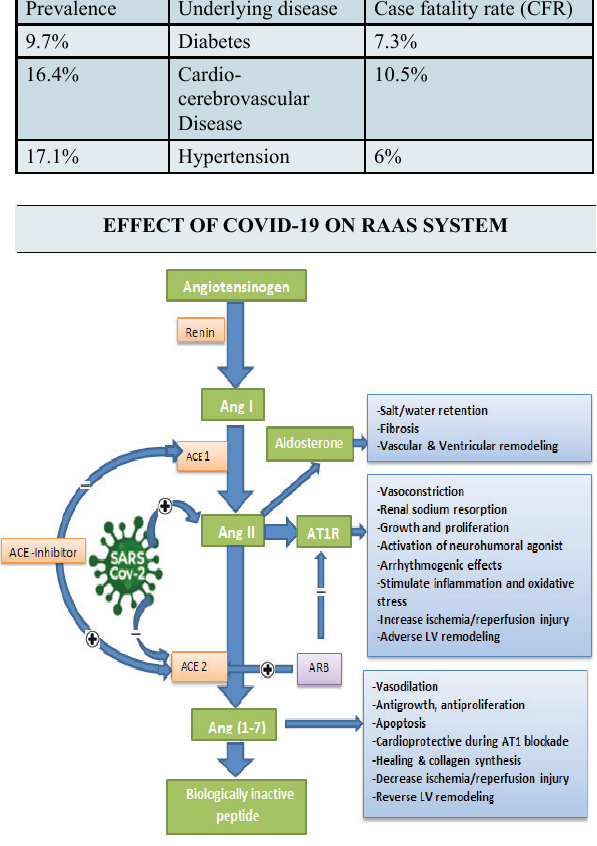
Figure 3: ACE mediated damage by SARS-CoV-2. (ACE- 1, Angiotensin-converting enzyme 1; ACE-2, Angiotensin- converting enzyme 2; Ang I, angiotensin I; AT1R, angiotensin II type 1 receptor)